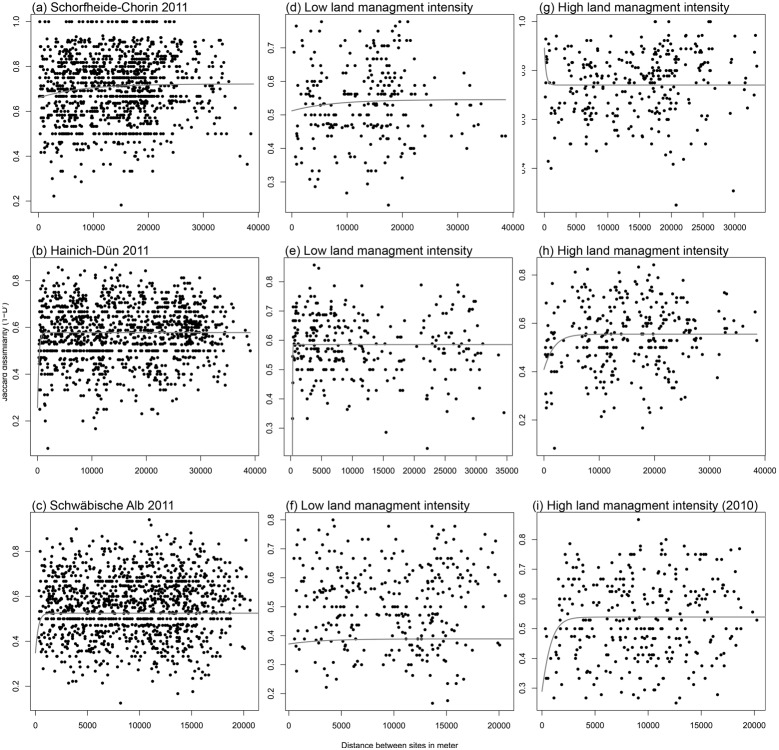
Dissimogram for the bird communities showing the Jaccard dissimilarity between each possible site pair versus Euclidian distance between the forests sites.(a–c) all sites in 2011, (d–f) sites with low land use intensity, and (g–i) sites with high land use intensity. The x-axis is the distance between each pair of sites. The grey line is the fitted line estimated based on non-linear least squares. Note the different scales in each x-axis.